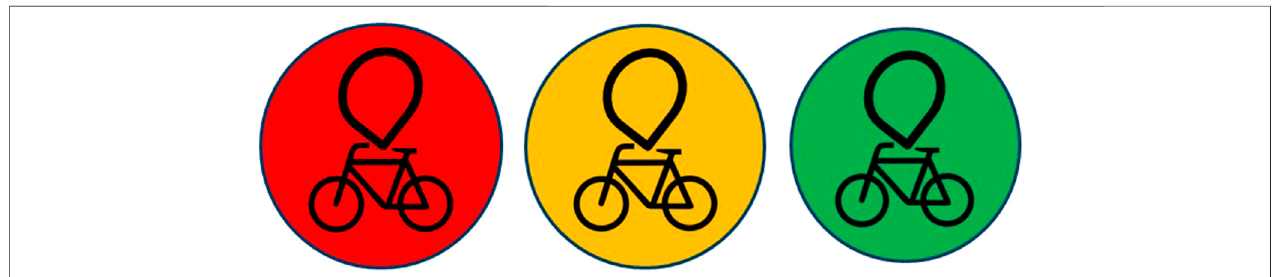
FIGURE5| Tokensgiventoparticipantsbefore TheHydrogenBike demonstration,aspartoftheinitialinteraction.Typically,a HydrogenBike teammemberbegins each interaction by asking the question: “ How do you feel about hydrogen? ” Red tokens correspond to negative responses, whereas green tokens signify a positive opinion. Yellow tokens are given to participants who offer no opinion on